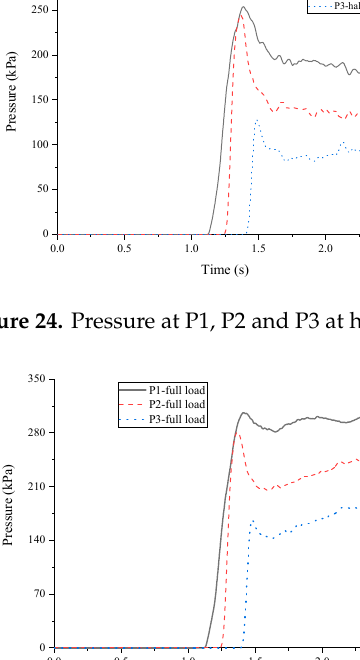
Figure 25. Pressure at P1, P2 and P3 at full load.